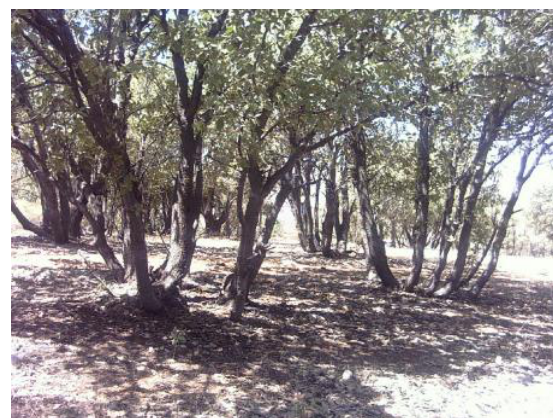
Figure 3. Coppice structure of Persian oak trees in the study